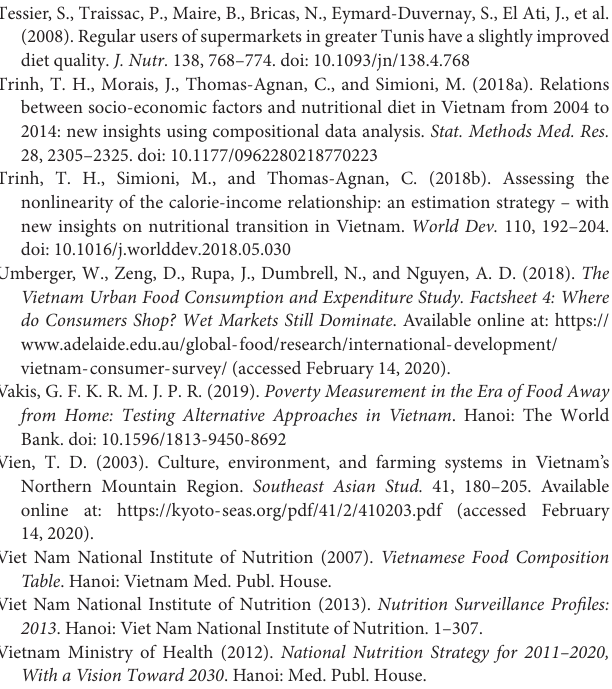
Table . Hanoi: Vietnam Med. Publ. House. Viet Nam National Institute of Nutrition (2013). Nutrition Surveillance Profiles: 2013 . Hanoi: Viet Nam National Institute of Nutrition. 1–307. Vietnam Ministry of Health (2012). National Nutrition Strategy for 2011–2020, With a Vision Toward 2030 . Hanoi: Med. Publ.